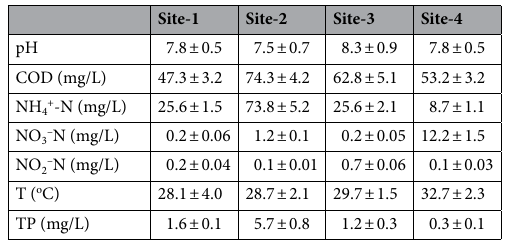
Table 1. Water quality and environmental parameters of the four sites.